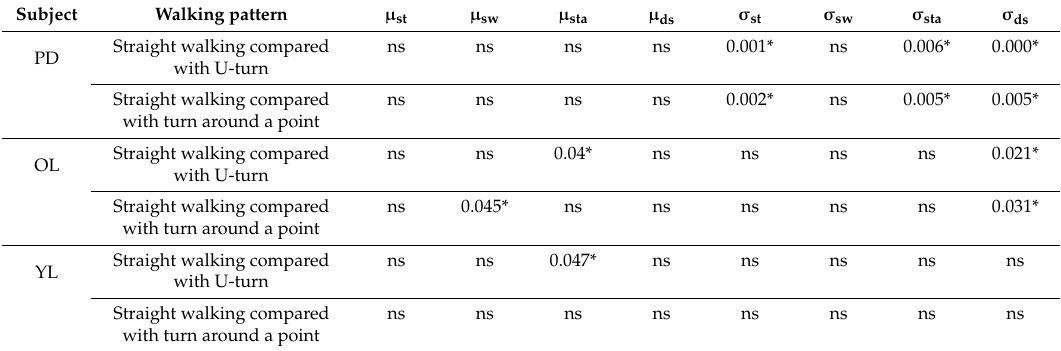
Table 2. The comparison of mean and coefficient of variance of gait intervals for straight with U ‐ turn and turn around a point for each subject group. The p -value is tabulated below.